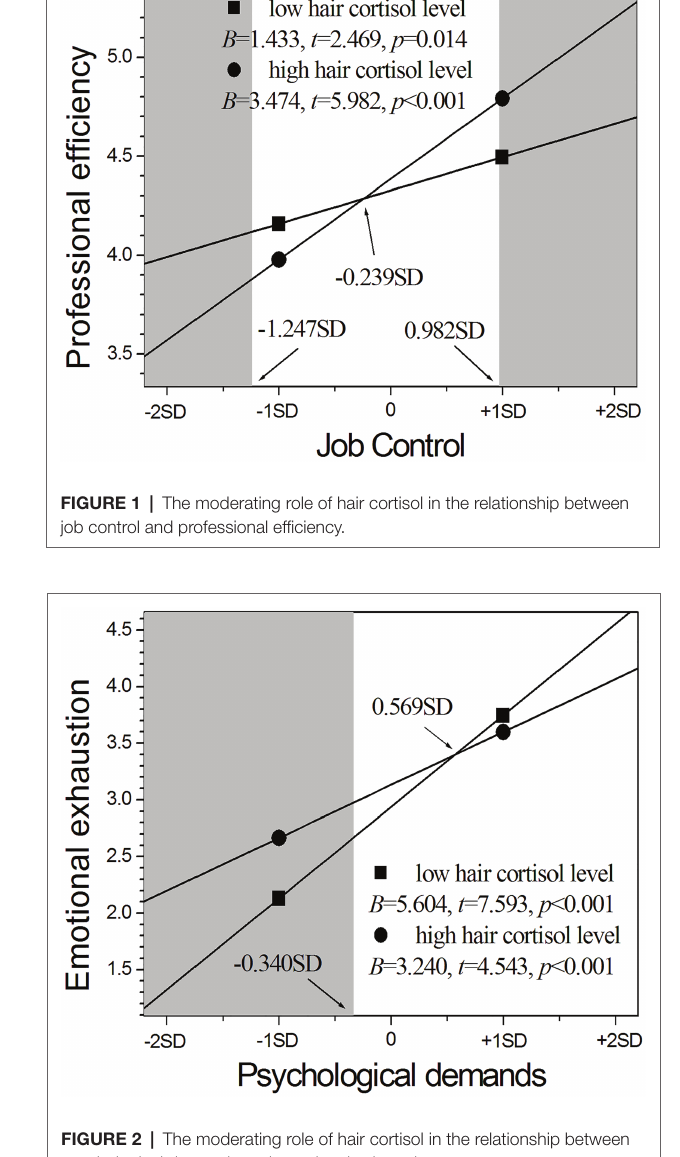
and the PA index was 0.47. These results seem to indicate that the interaction between psychological demands and HCC follows the vantage sensitivity model. As shown in Figure 3 , the stronger influence of coworker support on professional efficiency existed in nurses with low cortisol levels ( B = 0.236, p < 0.001) than those with high cortisol levels ( B = 0.019, p > 0.05). The RoS results further revealed that nurses with low cortisol levels had significantly higher professional efficiency than those with high cortisol levels in the context of higher coworker support above 1.069 SD from the mean (see the right shaded area in Figure 3 ) and had significantly lower professional efficiency in the context of lower coworker support below − 0.643 SD from the mean T A